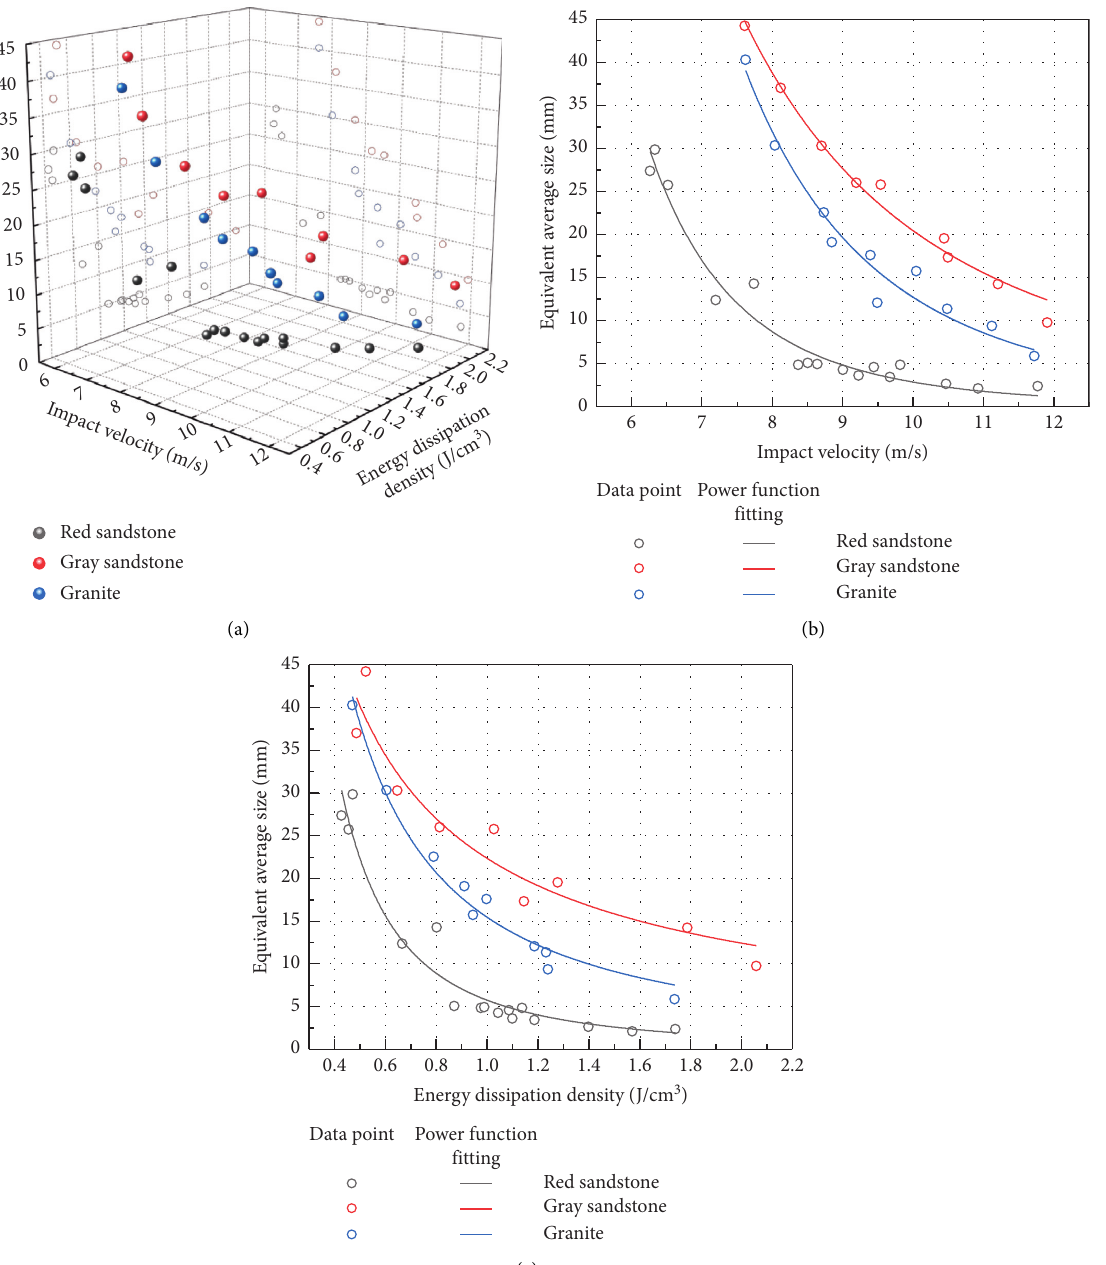
Figure 18: Equivalent average size-impact velocity-energy dissipation density diagram: (a) three dimensional diagram, (b) equivalent average size-impact velocity diagram, and (c) equivalent average size-energy dissipation density